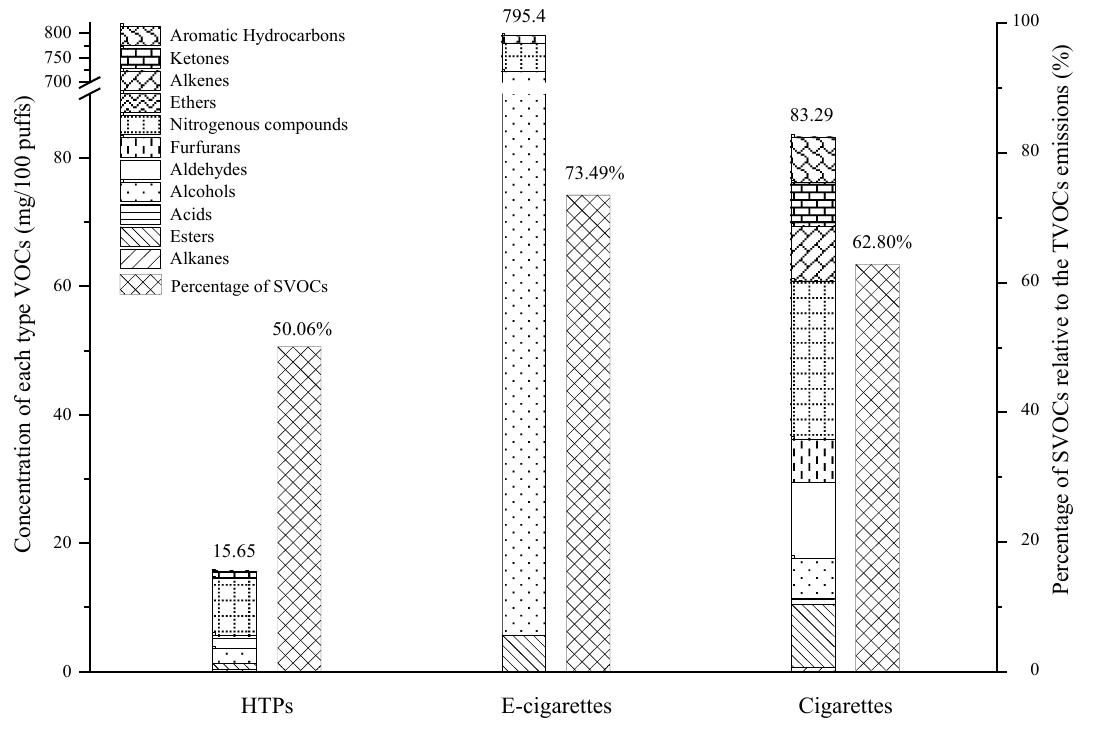
Figure 3. Types of VOCs produced by three types of tobacco products and the percentage of semi- VOCs (SVOCs) relative to the total VOCs (TVOCs) emission.